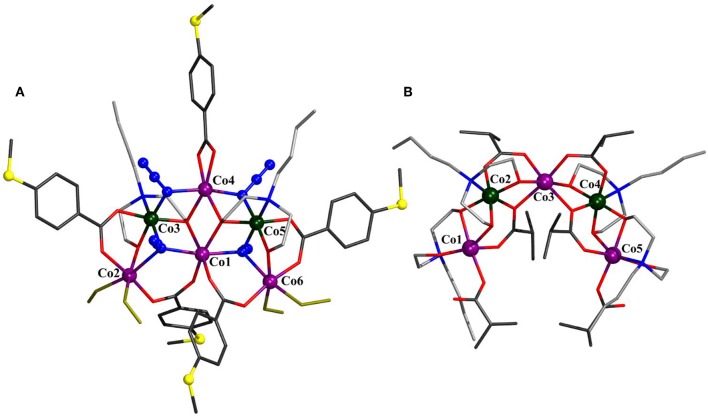
Molecular structure of [Co4IICo2III(N3)4(N-n-bda)2(bza·SMe)5(MeOH)4]+ in 2 (A) and comparison to [Co3IICo2III(N-n-bda)2(N-n-Hbda)2(ib)6] (Schmitz et al., 2016a) (B). Hydrogen atoms, Cl− counterion, and co-crystallized solvent molecules are omitted for clarity. The cobalt, sulfur, and the nitrogen atoms of azides are represented as ball-and-stick models. Color code: C (carboxylates) = dark gray; C (N-n-Hbda− and N-n-bda2−) = gray; N = blue; O = red; S = yellow; coordinated MeOH molecules = yellow sticks; CoII = violet; CoIII = dark green. See Supporting Information for detailed crystal packing of the complexes.